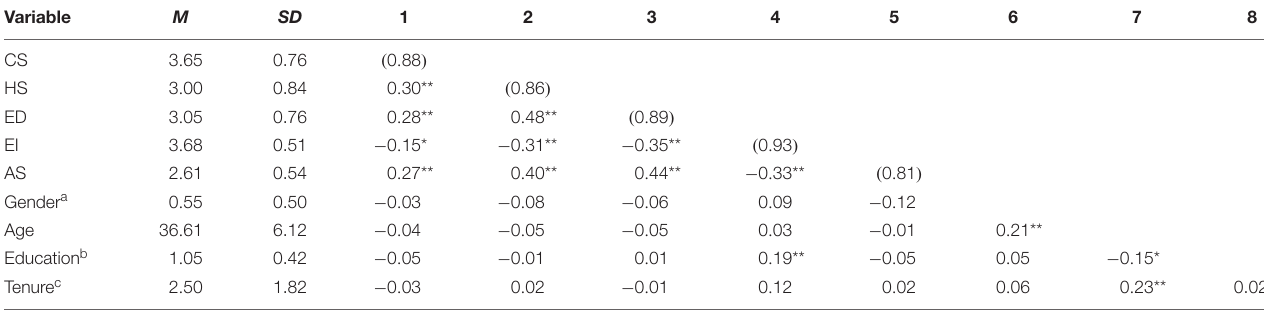
TABLE 2 | Descriptive statistics and correlations.